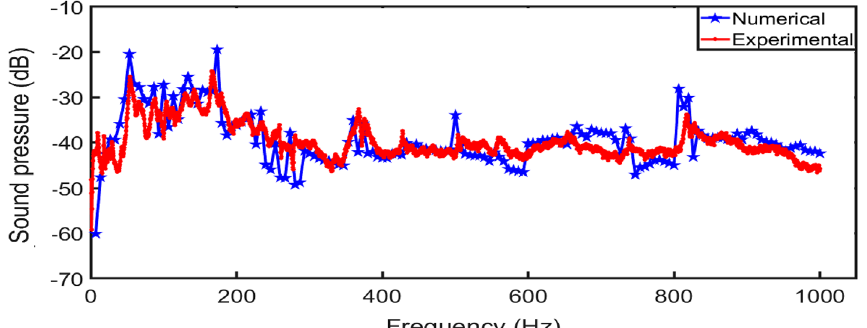
Figure 9. Comparison of the acoustic radiation in terms of averaged sound pressure between experimental measurement and numerical